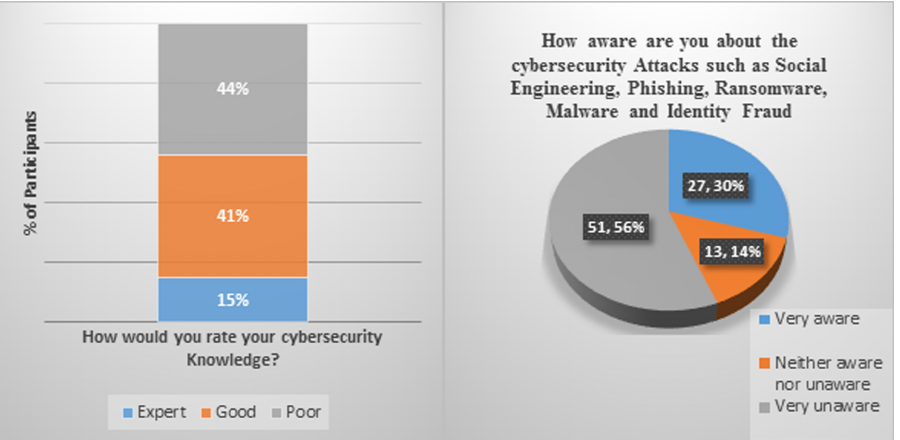
Figure 13. Cybersecurity Knowledge and Awareness Survey